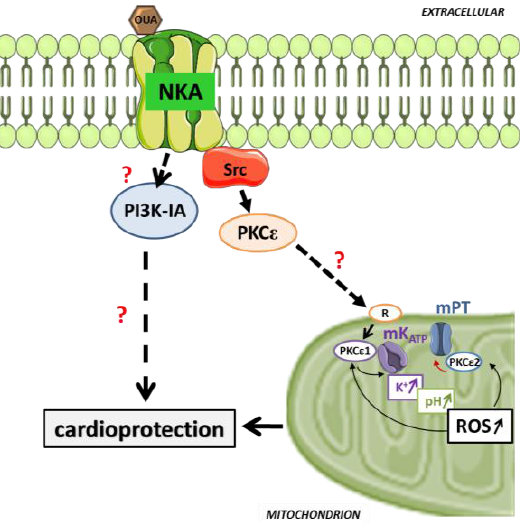
Figure 2. The ouabain preconditioning signaling pathway. Na/K-ATPase/Src activation precedes PKC ε activation and translocation. An intramitochondrial pathway involves PKC ε activation (PKC ε 1) and mKATP channel opening as a functional complex to trigger an increase in K + -uptake in the mitochondrial matrix. The mKATP-dependent matrix alkalinization is crucial in intramitochondrial signaling, leading to ROS production, which activates the second PKC ε , PKC ε 2. PKC ε 2 inhibits the mitochondrial permeability transition pore(mPT) in a phosphorylation-dependent reaction. Furthermore, PKC ε 1 sustains the open state of mKATP channel through mKATP-dependent ROS activation. In addition to this mitochondrial cardioprotective signaling, ouabain-induced PI3K-IA activation is required for protection by OPC. The inhibition of either PKC ε or PI3K-IA blunts